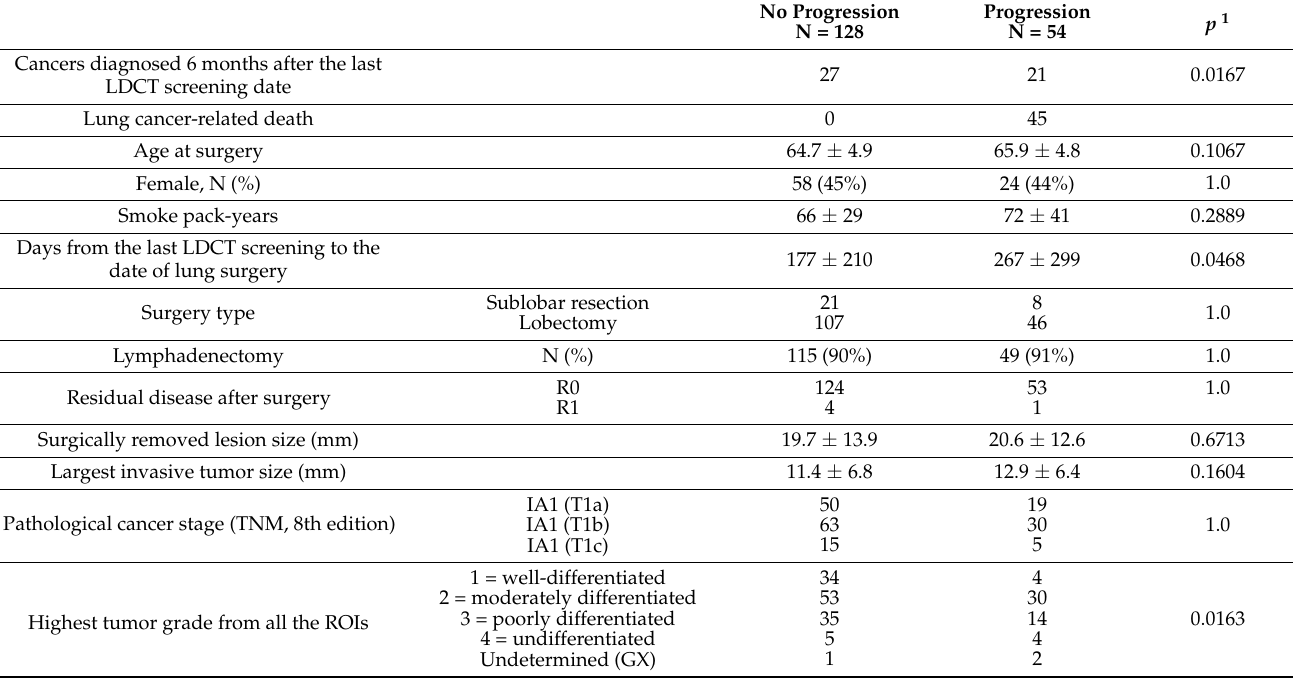
Table 1. Summary of the study sample. Cancer progression is defined as a competing event from any of the following events during the 12-year follow-up after the primary tumor surgery: lung cancer recurrence, metastasis, or lung cancer-related